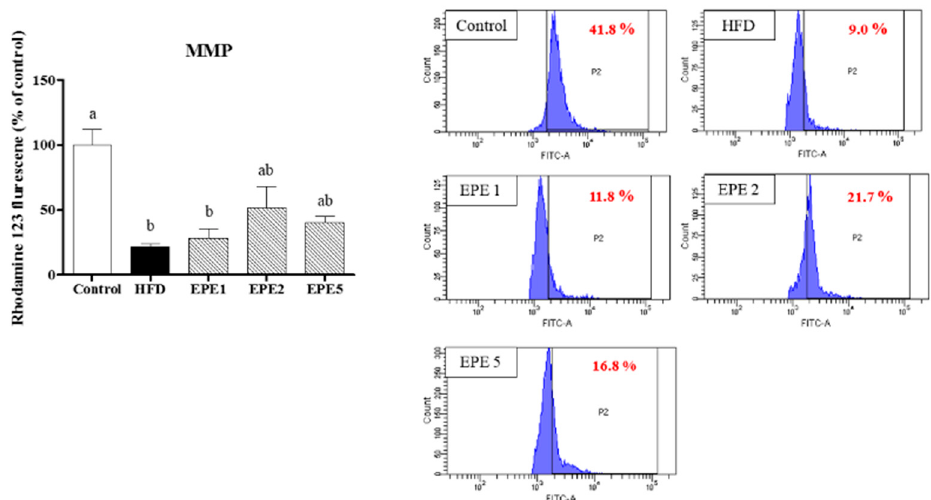
Figure 11. Effects of Echinacea purpurea ethanol extract in the sperm mitochondrial membrane potential in HFD-induced obese rats after 5 weeks. Data are shown as the mean ± S.E.M. (n = 5). The values with different superscript letters (a,b) are significantly different ( p < 0.05), as determined via one-way ANOVA, and were analyzed by Duncan’s multiple range test.